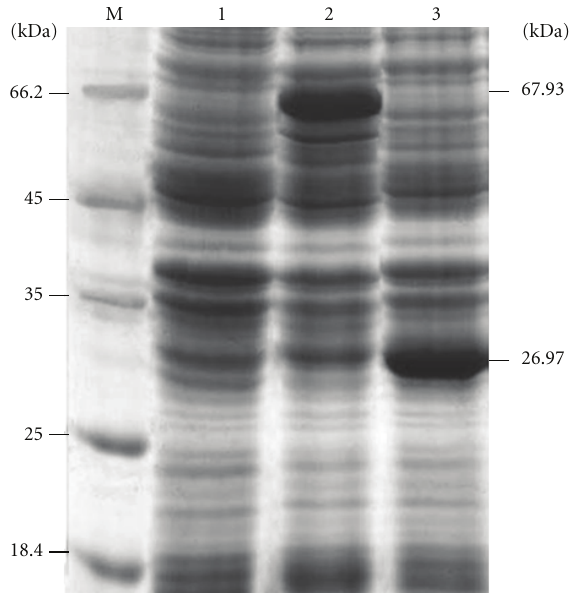
Figure 3: SDS-PAGE analysis of the fusion protein produced in the recombinant E. coli BL 21 (DE3). M: Protein Marker; (1) E. coli strain; (2) E. coli strain harboring pGEX-4T-1- AhFatA ; (3) E. coli strain harboring